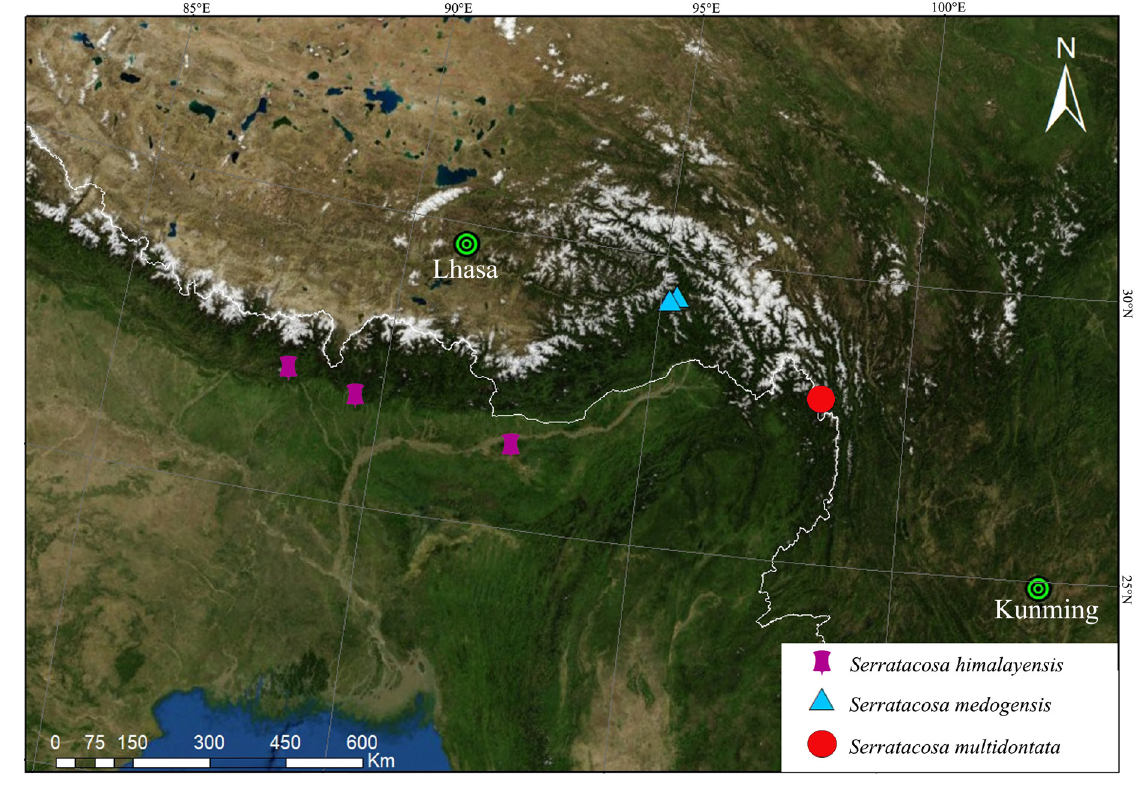
Fig. 6. Distribution of Serratacosa gen.